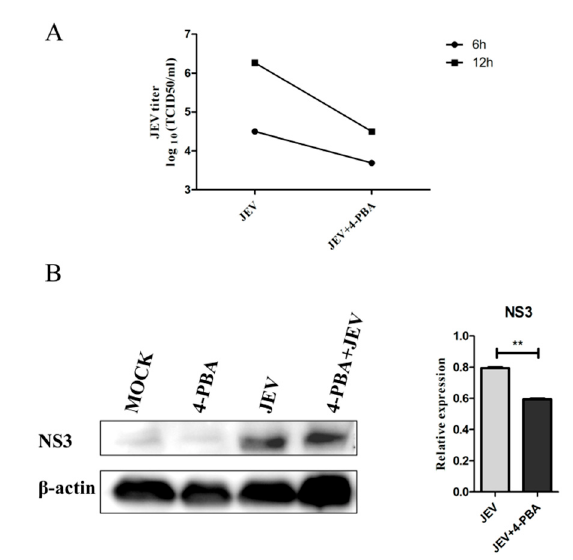
Figure 1. The titer of JEV virus decreased after treatment of 4-PBA. JEV (MOI 1.5) and 4-PBA of 1 mM/mL were used to treat BV2 cells. ( A ) JEV titers at 6 hpi and 12 hpi; the cell supernatant was measured by TCID50 assays. ( B ) The western blot at 12 h was used to test the NS3 protein expression of JEV. β -actin was used as sample loading control. ** p < 0.01.